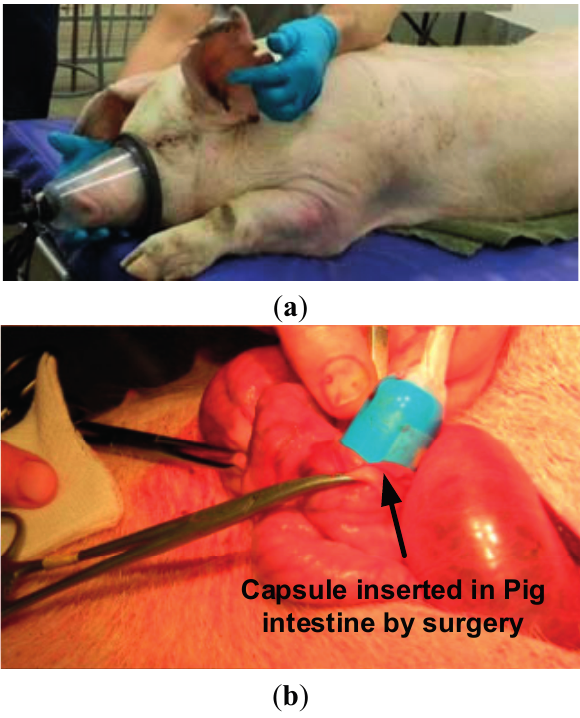
Figure 13. ( a ) Live pig under anesthetic at the Prairie Swine Center, Saskatoon, SK, Canada; ( b ) capsule inserted in live pig’s intestine by surgery.